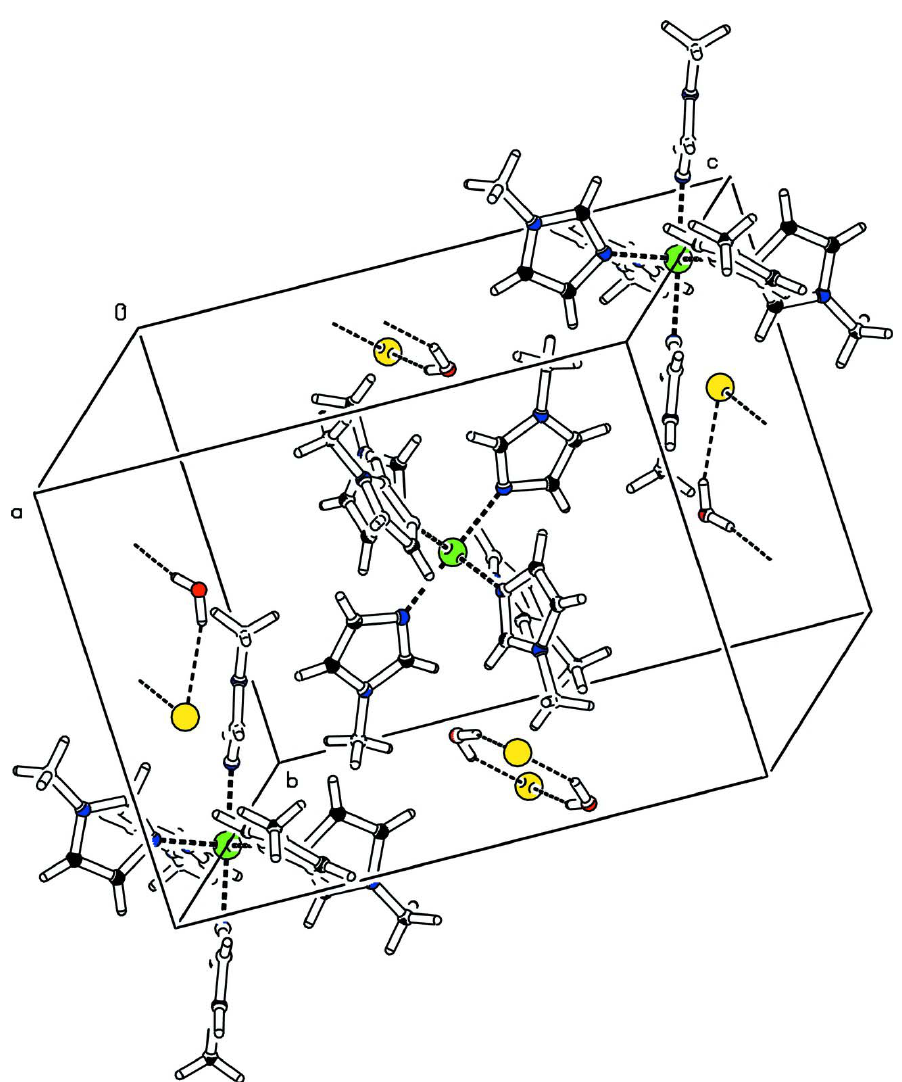
A partial packing diagram of the title compound. Hydrogen bonds are shown as dashed